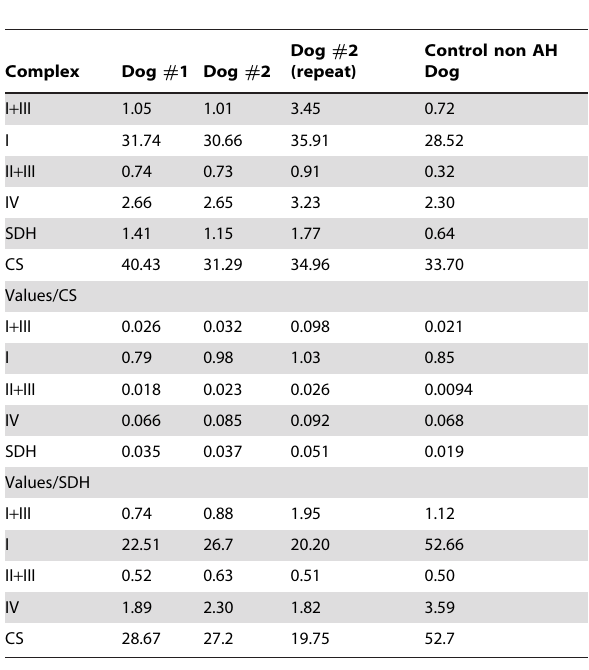
*SDH = succinate:dehydrogenase; CS = citrate synthase.